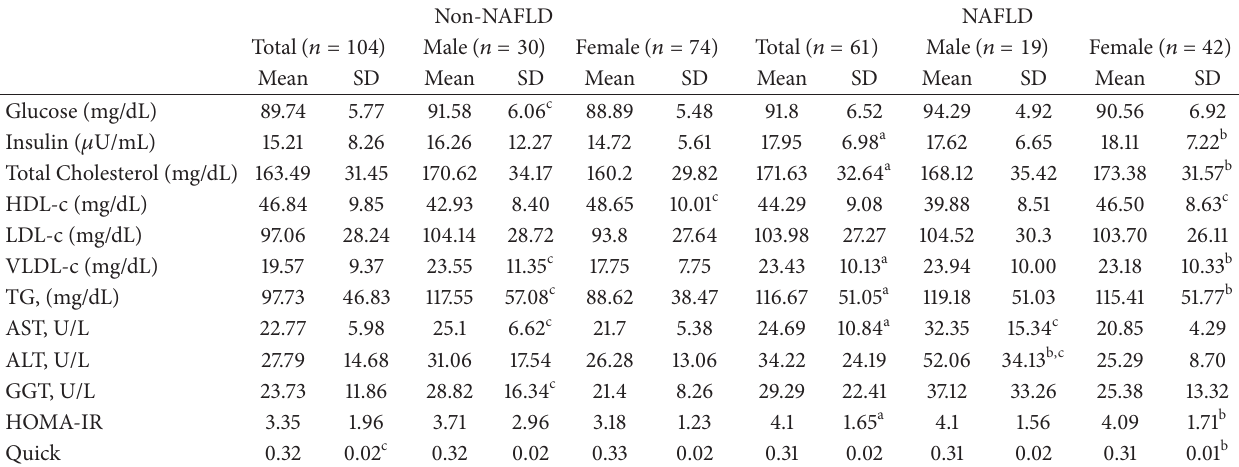
Table 2: Biochemical characteristics of the studied population.